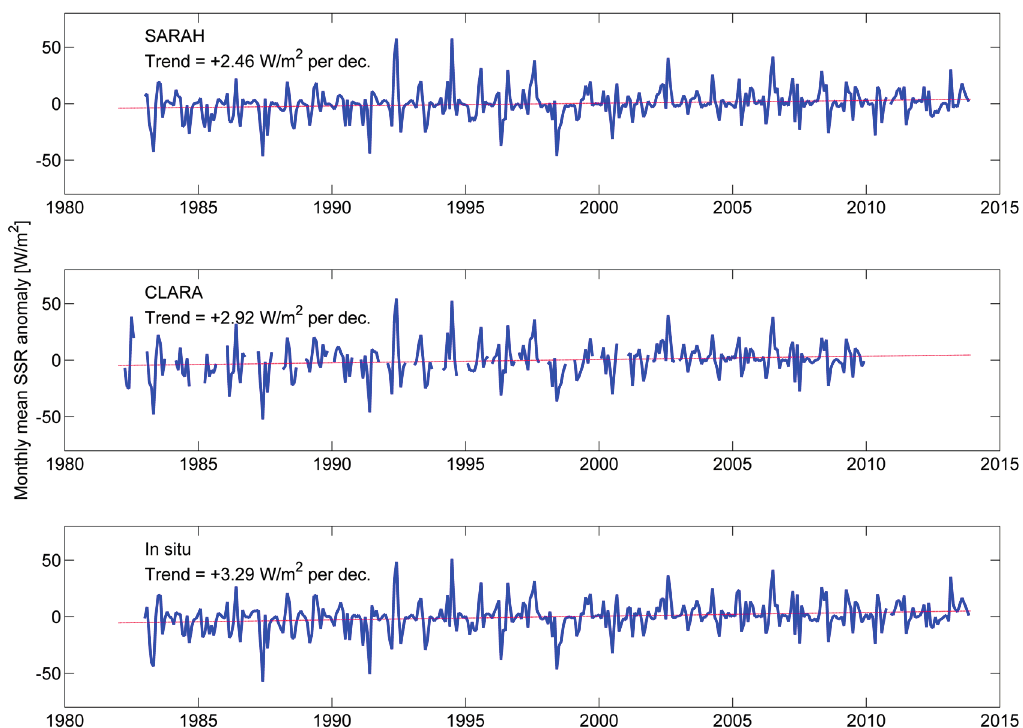
Figure 7. Trends of the monthly mean SSR anomalies of the employed datasets. Anomalies calculated only for months where both satellite estimate and in situ observation have valid values. All validation sites averaged together. All anomalies calculated per-month against that month’s mean SSR over the dataset